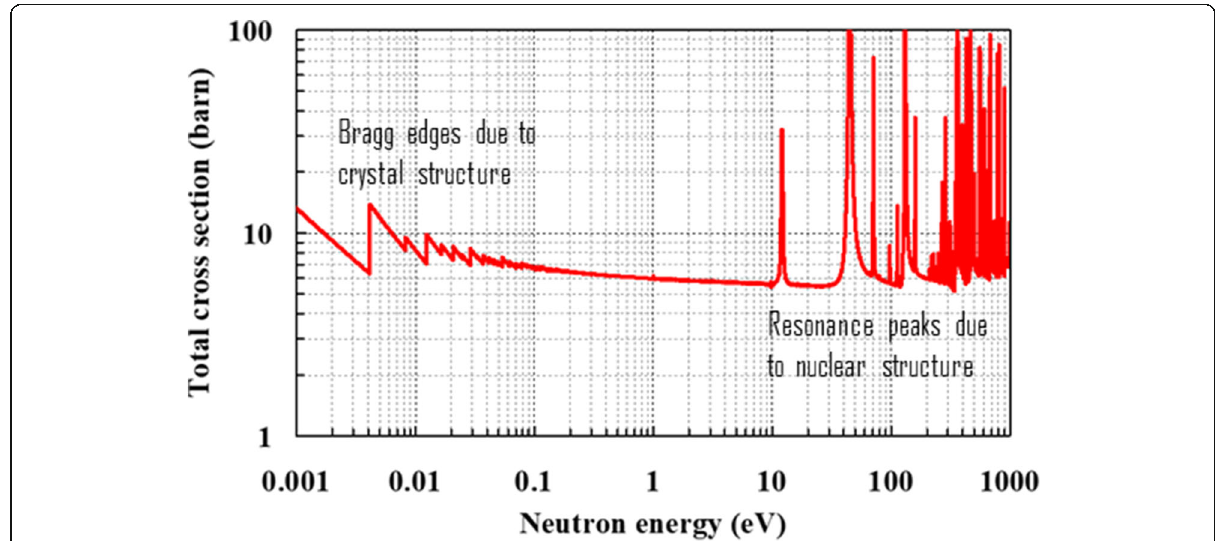
Fig. 8 An example of the neutron cross